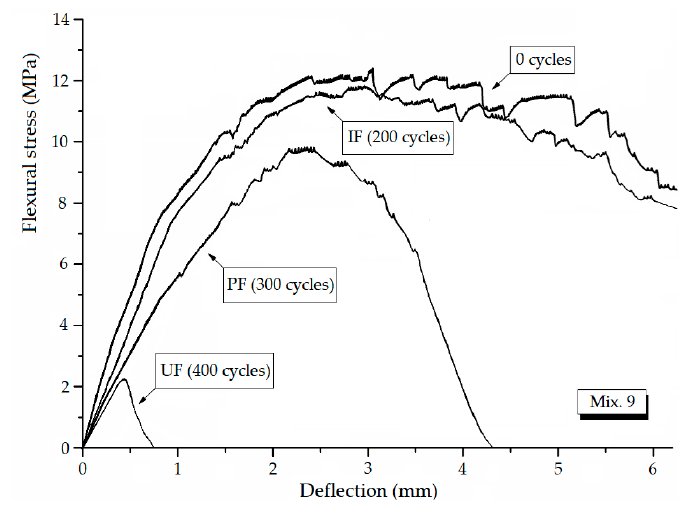
Figure 14. The changing flexural behavior of typical ECC mixture.